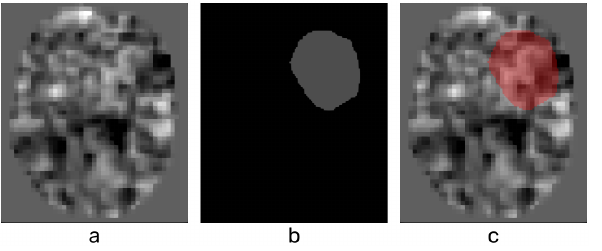
Figure 5. LANG Network ( a ), Lesion mask ( b ) and Mask overlay on Network activation ( c